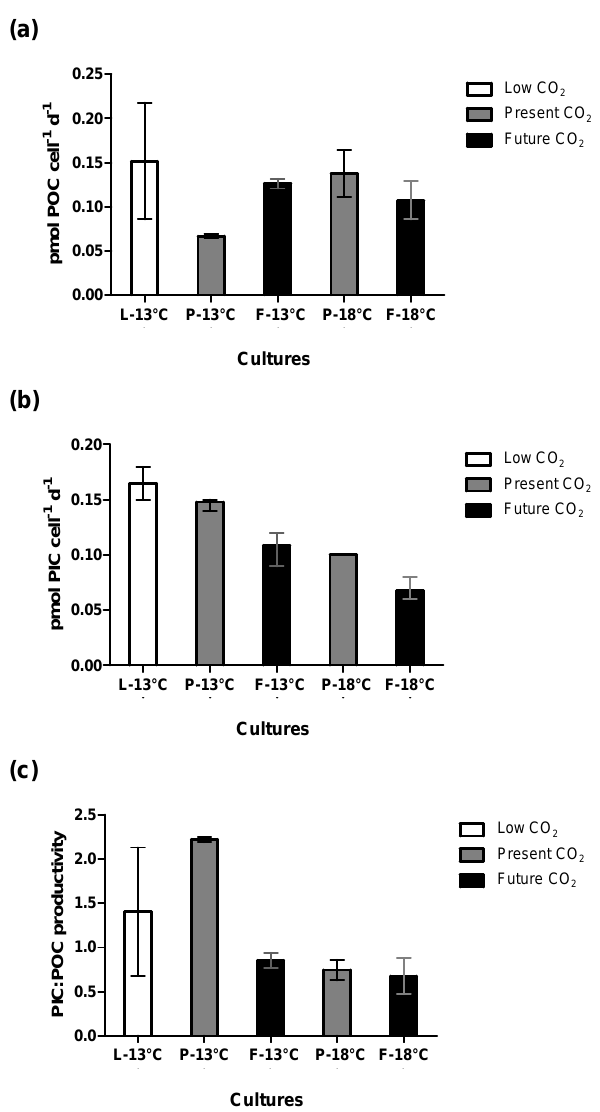
Fig. 3. (a) Cellular POC production rate, (b) cellular PIC produc- tion rate and (c) PIC:POC productivity ratio during the exponential phase of the batch culture experiments. Bars represent the mean of the duplicate cultures and the whiskers represent the minimum and maximum